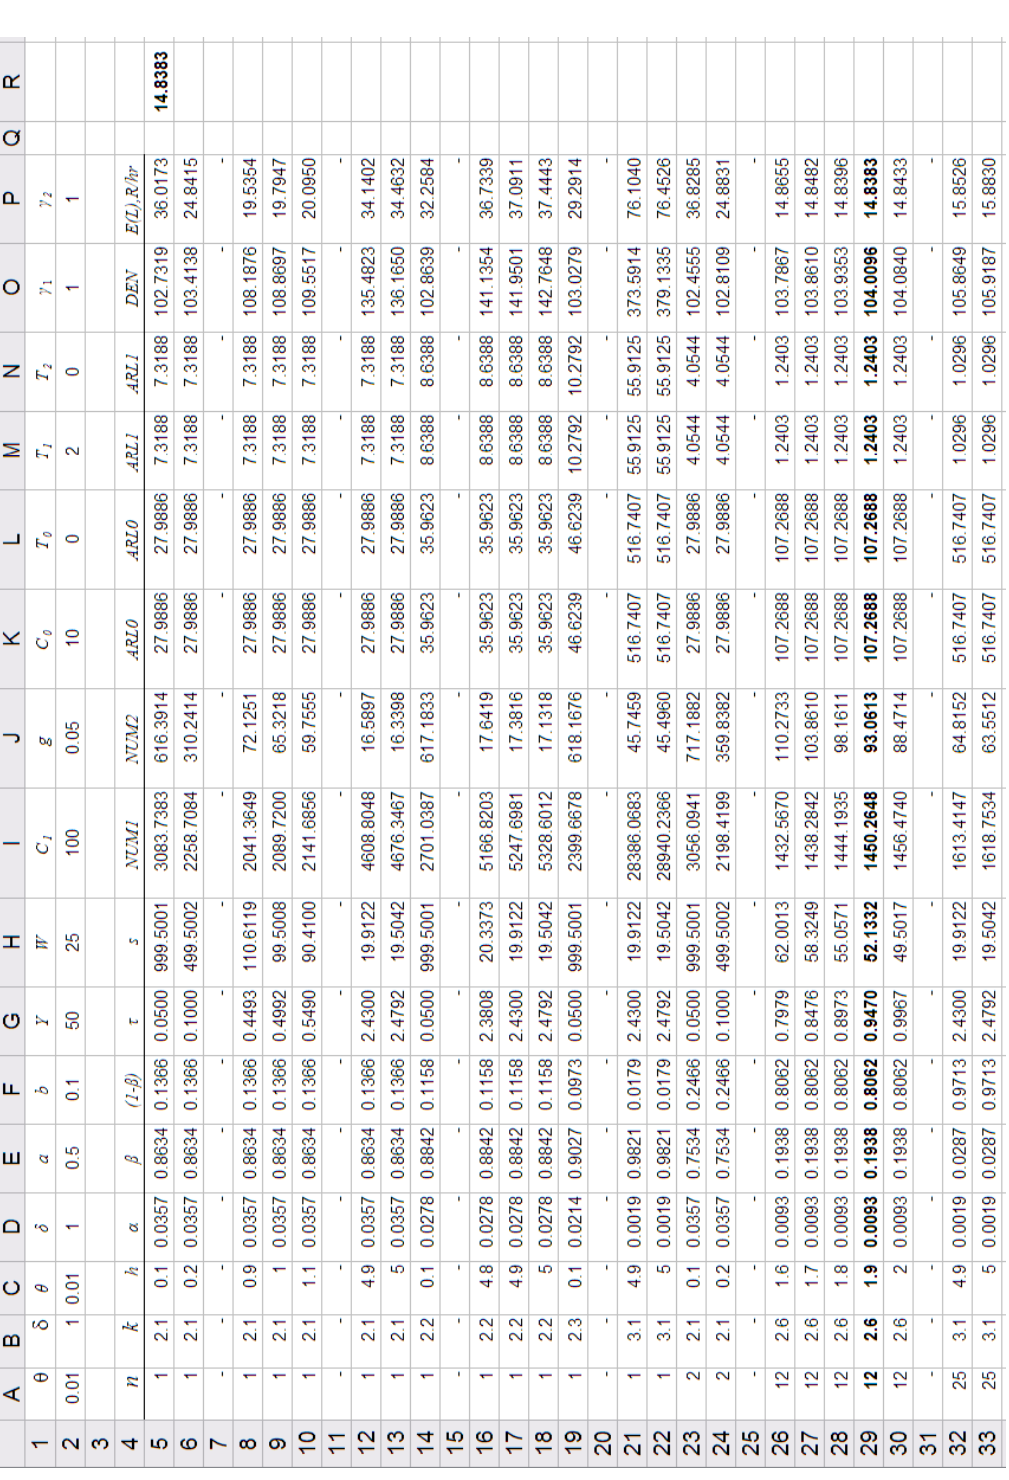
Figure 1: Screen shot of the Excel worksheet in which the model described in this paper has been